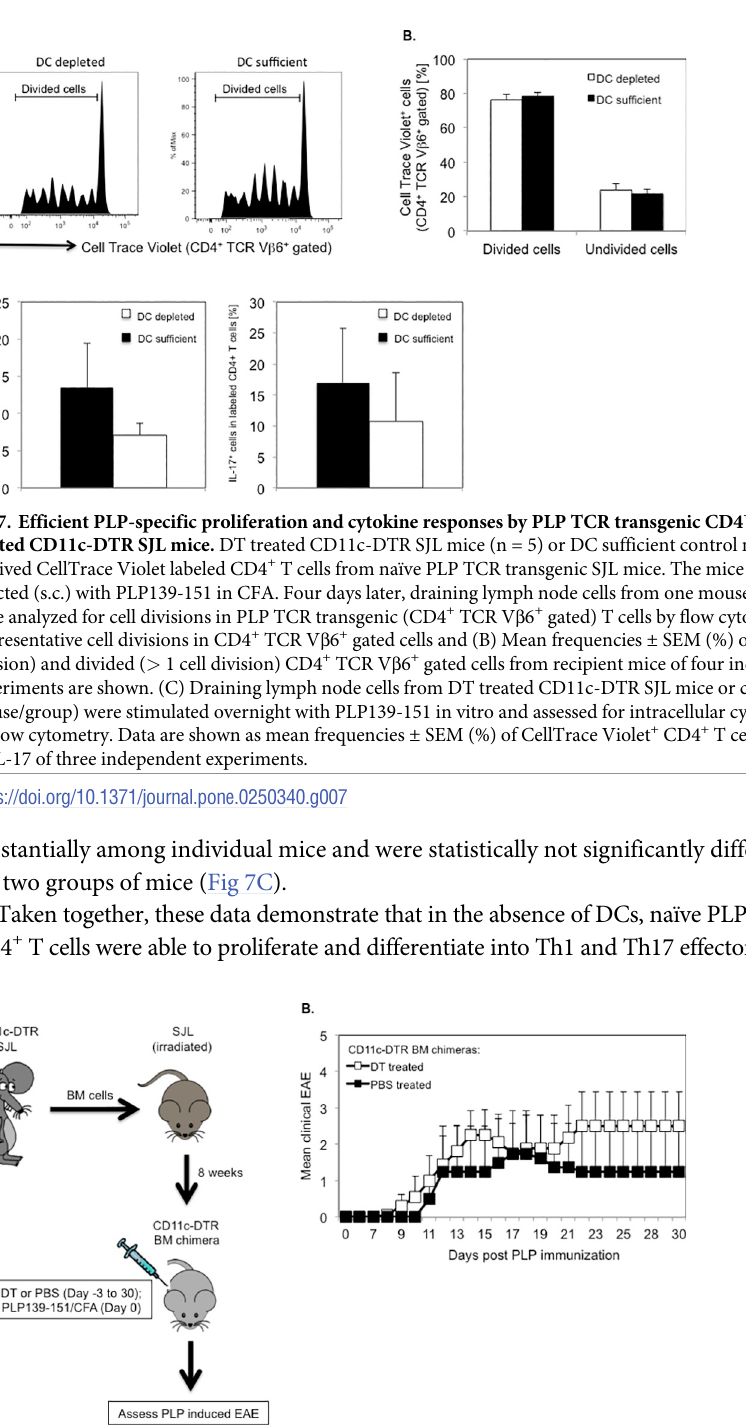
Fig 8. Long term DT treated CD11c-DTR SJL bone marrow chimeric mice are susceptible to PLP-induced EAE. (A) Schematic representation of the generation of CD11c-DTR SJL BM chimeric mice and assessment of PLP-induced EAE in long term DT or PBS treated chimeras. (B) EAE was induced in DT (n = 8) or PBS (n = 4) treated CD11c-DTR SJL BM chimeric mice by injection of PLP139-131/CFA (s.c.) and PT (i.v). The mice were examined daily for clinical signs of EAE for 30 days during which they received DT or PBS on every other day. Data are shown as mean clinical EAE ±